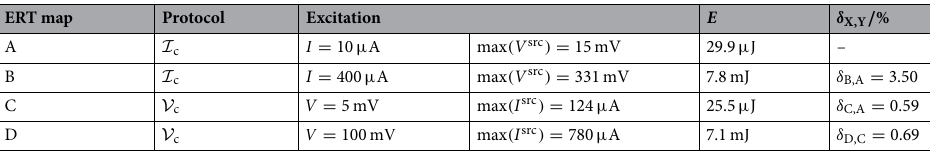
Table 1. ERT settings and relevant quantities corresponding to the sample S . For each map shown in Fig. 2 are reported: the protocol, the excitation quantities, the total energy dissipated during the measurement and the map difference with respect to the chosen reference.